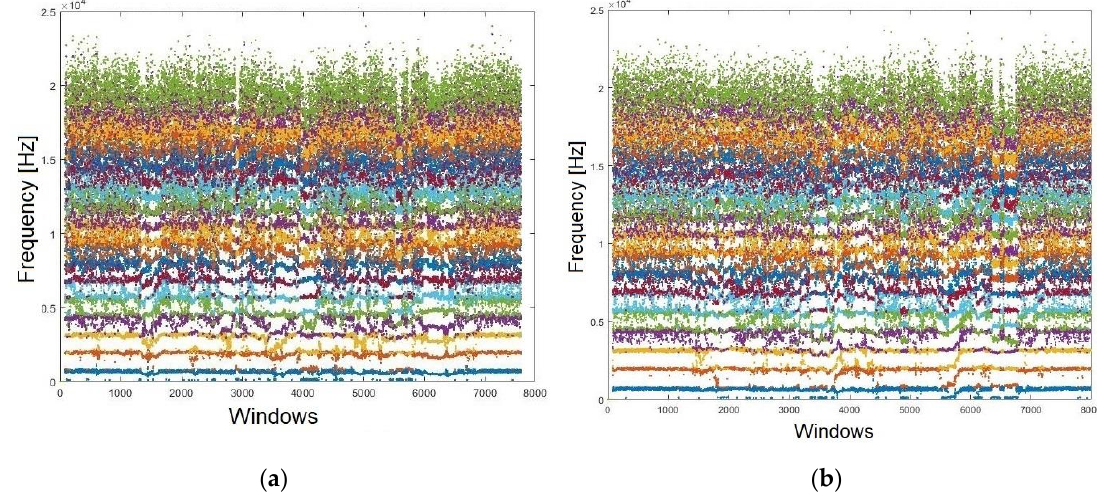
Figure 5. Formants (N = 19) extracted from both audios: (a) confronted; (b) reference.